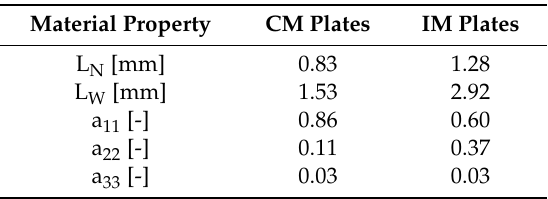
Table 1. Fiber properties. Average FLs, a 11 , a 22 , and a 33 as the orientation tensors. a 11 representing extrusion direction in compression molded samples and the melt flow direction in injection molded samples.